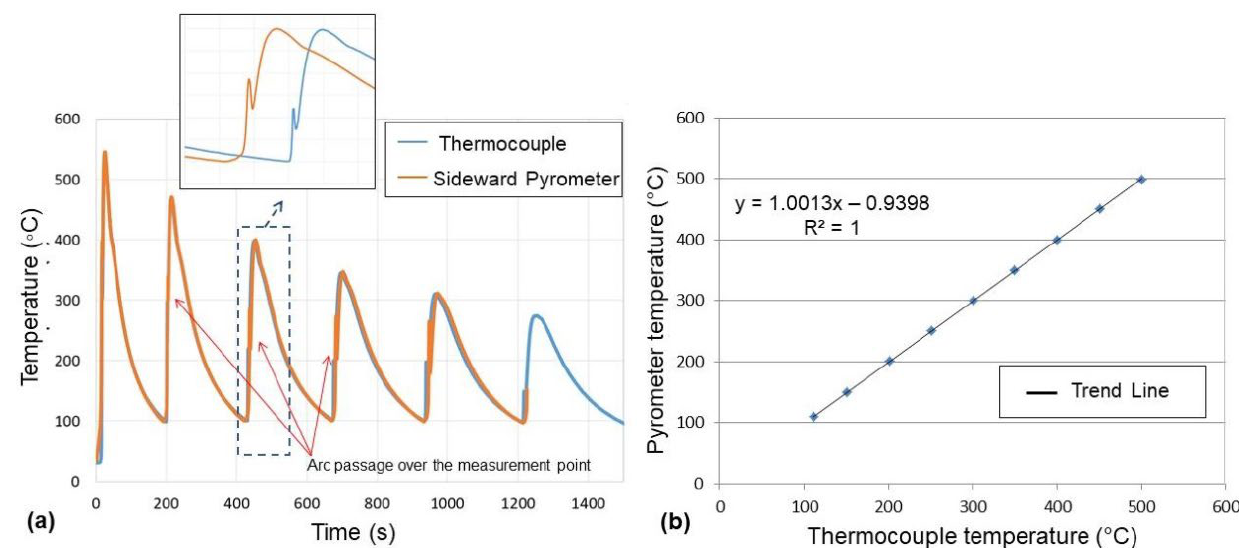
Figure 7. ( a ) Temperature profiles as a function of time, recorded by the thermocouple and the sideward pyrometer, within a measurement range between approximately 100 °C and 550 °C, with the emissivity coefficient (ε set ) set to 0.90 (note a magnification of a signal lag to evidence punctual noises); ( b ) corresponding fitting curve and calibration equation.